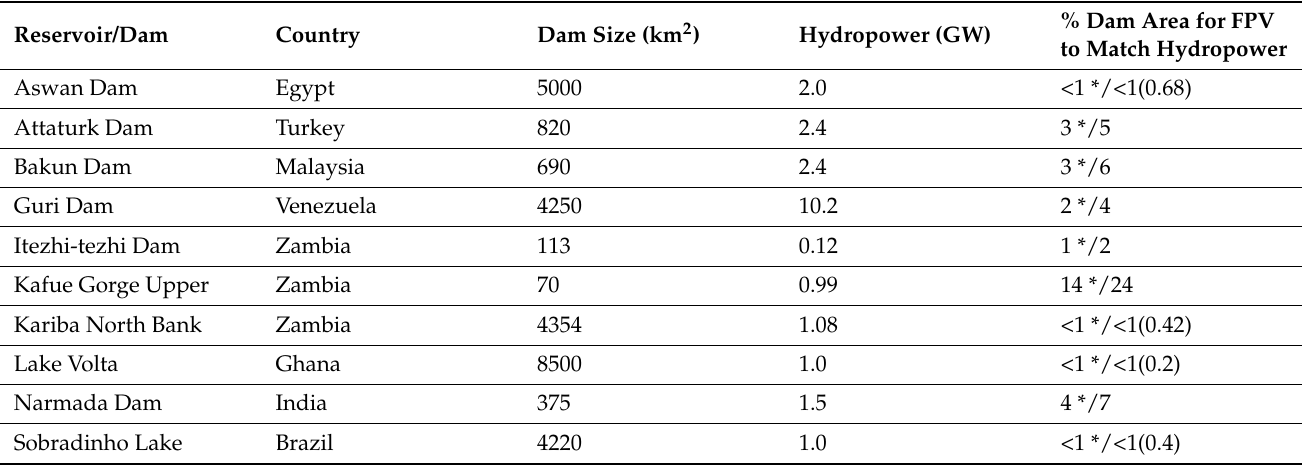
Table 1. Showing estimated reservoir size and power generation to match hydropower capacity ([1] and authors’ compila- tion). Reproduced from [1], the name of the publisher: ESMAP